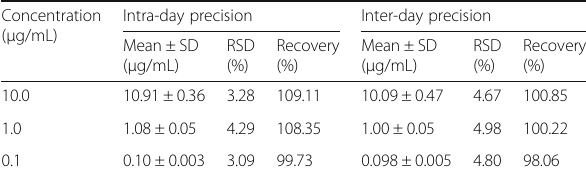
Table 2 Results of the precision and recovery test Concentration ( μ g/mL)